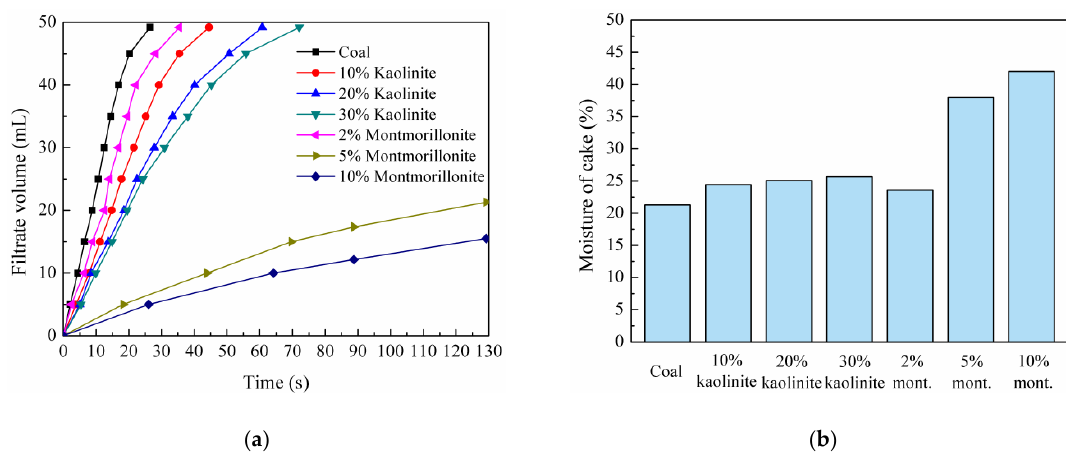
Figure 4. ( a ) Filtrate volume as a function of time, and ( b ) moisture of the filter cake for dewatering of coal slurries with different contents of kaolinite and montmorillonite.